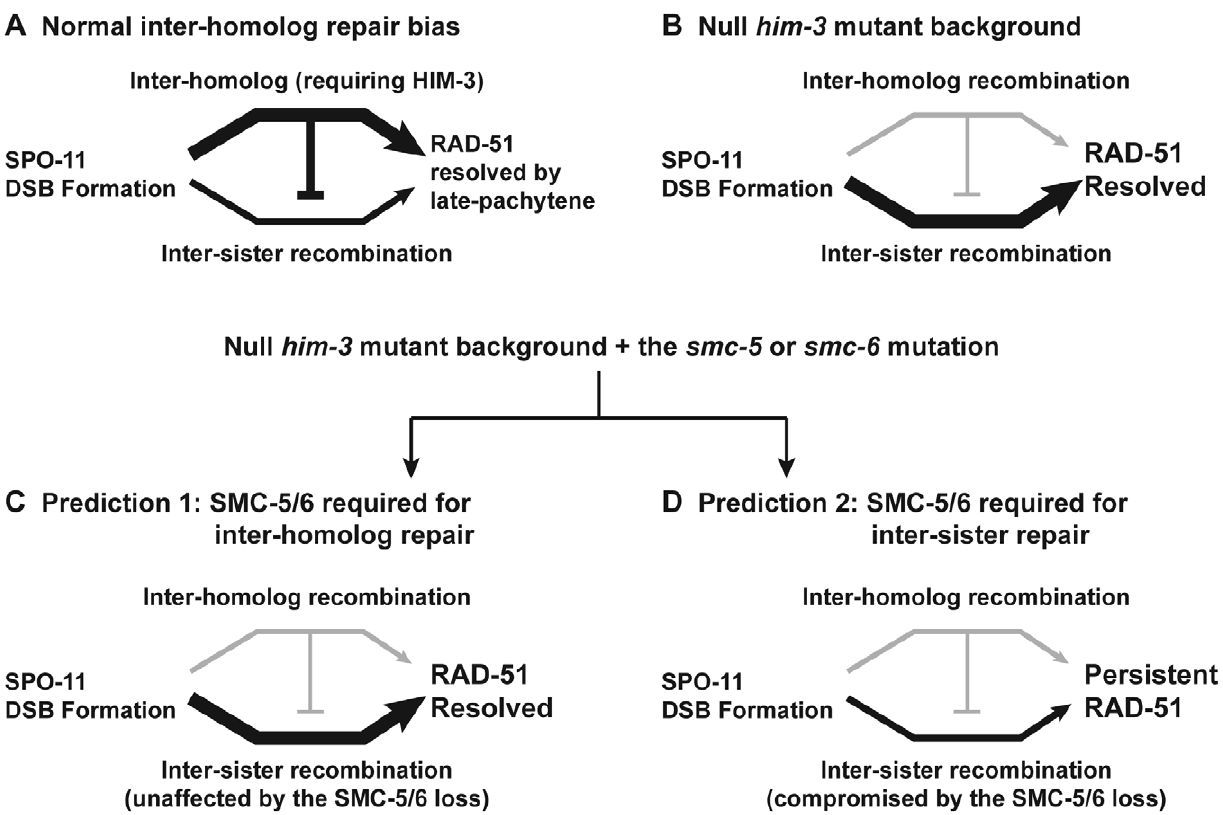
Figure 6. Possible outcomes for the combined genetic disruptions of smc-5 or smc-6 and him-3 . (A) Schematic diagram depicts the biased repair of SPO-11 DSBs via inter-homolog recombination repair in meiosis. (B) In the absence of HIM-3, SPO-11 DSBs are repaired via homolog- independent ( i.e. sister-chromatid) recombination [48]. (C–D) Two predicted repair outcomes for the double mutants. (C) If the SMC-5/6 proteins function mainly in inter-homolog repair which is already disrupted by the him-3 mutation, then the overall repair efficiency as monitored by the removal of RAD-51 staining should be the same in the double mutants as compared to the smc-5 and smc-6 single mutants. (D) If the SMC-5/6 proteins function mainlyin inter-sister repair, then the double mutantshould exacerbate therepairdefects and the RAD-51intermediates should persist at late